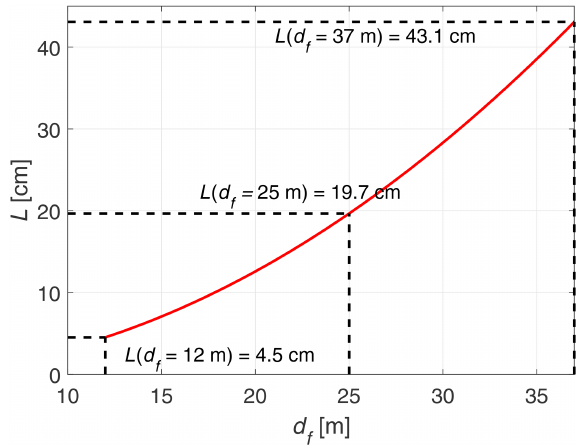
Figure 6. Plot of the theoretical probe length L of the 6in. aperture WindScanner for the applied focus distance d f ranging from 12 to